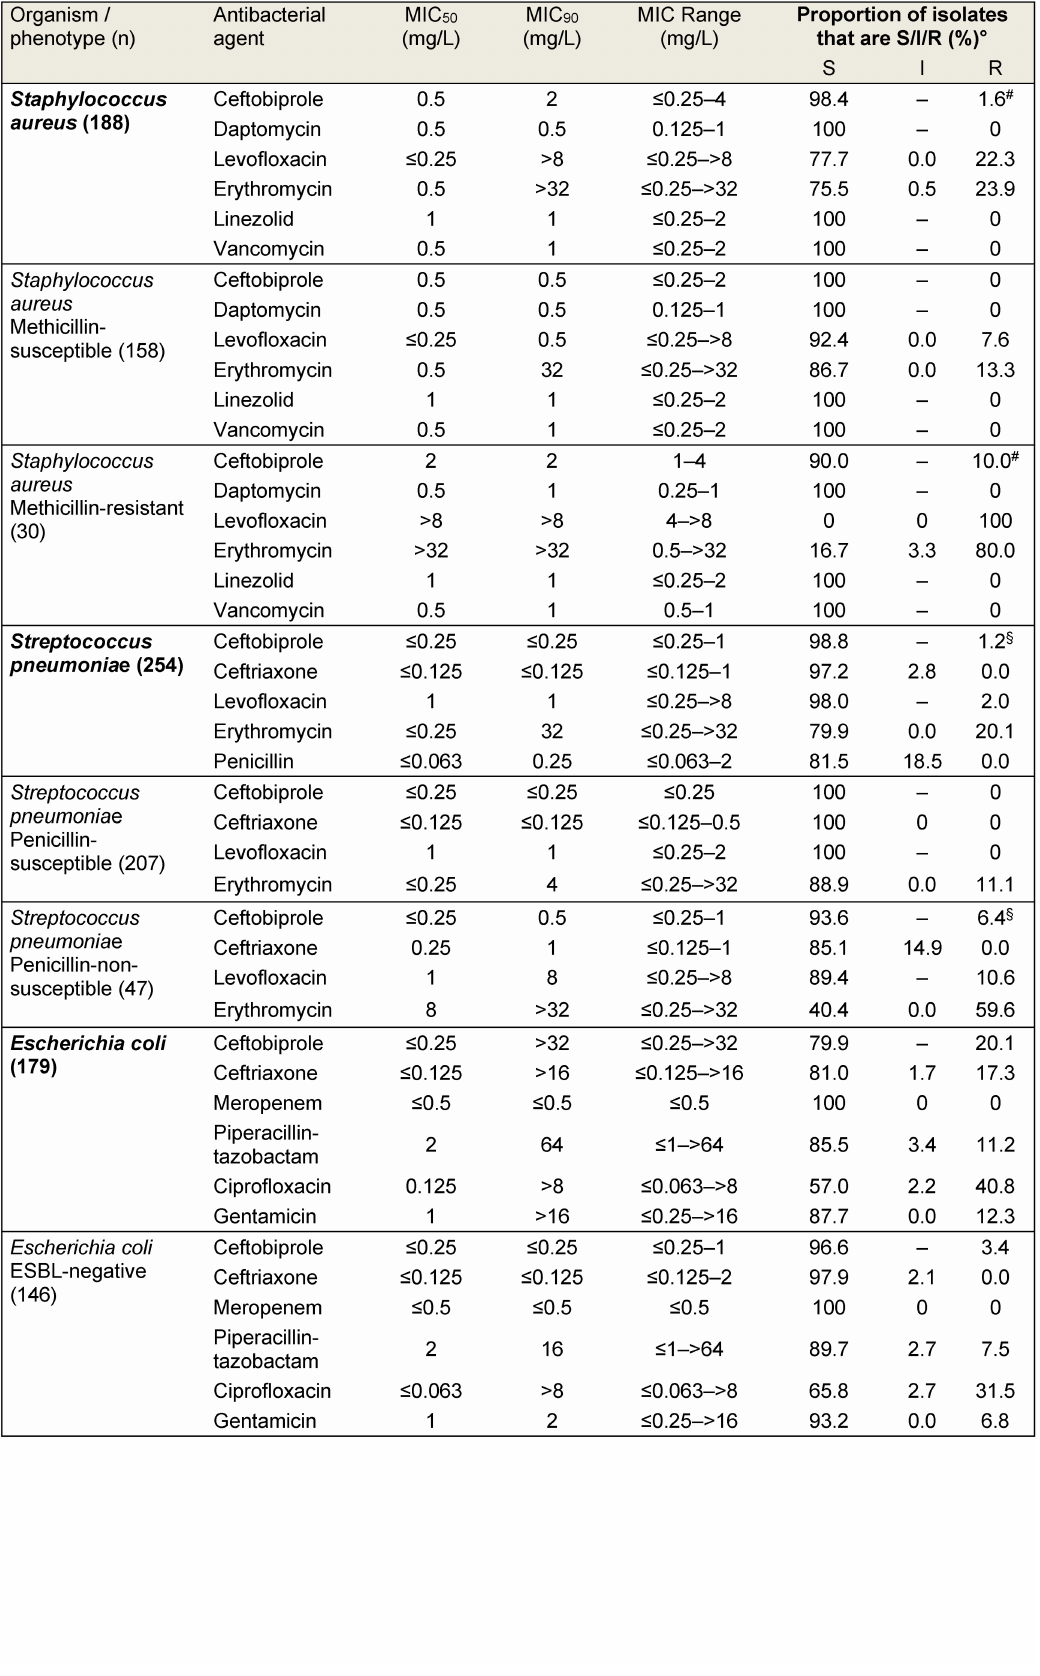
Table 3: In vitro activity of ceftobiprole and comparators against clinical isolates of most frequent bacterial species